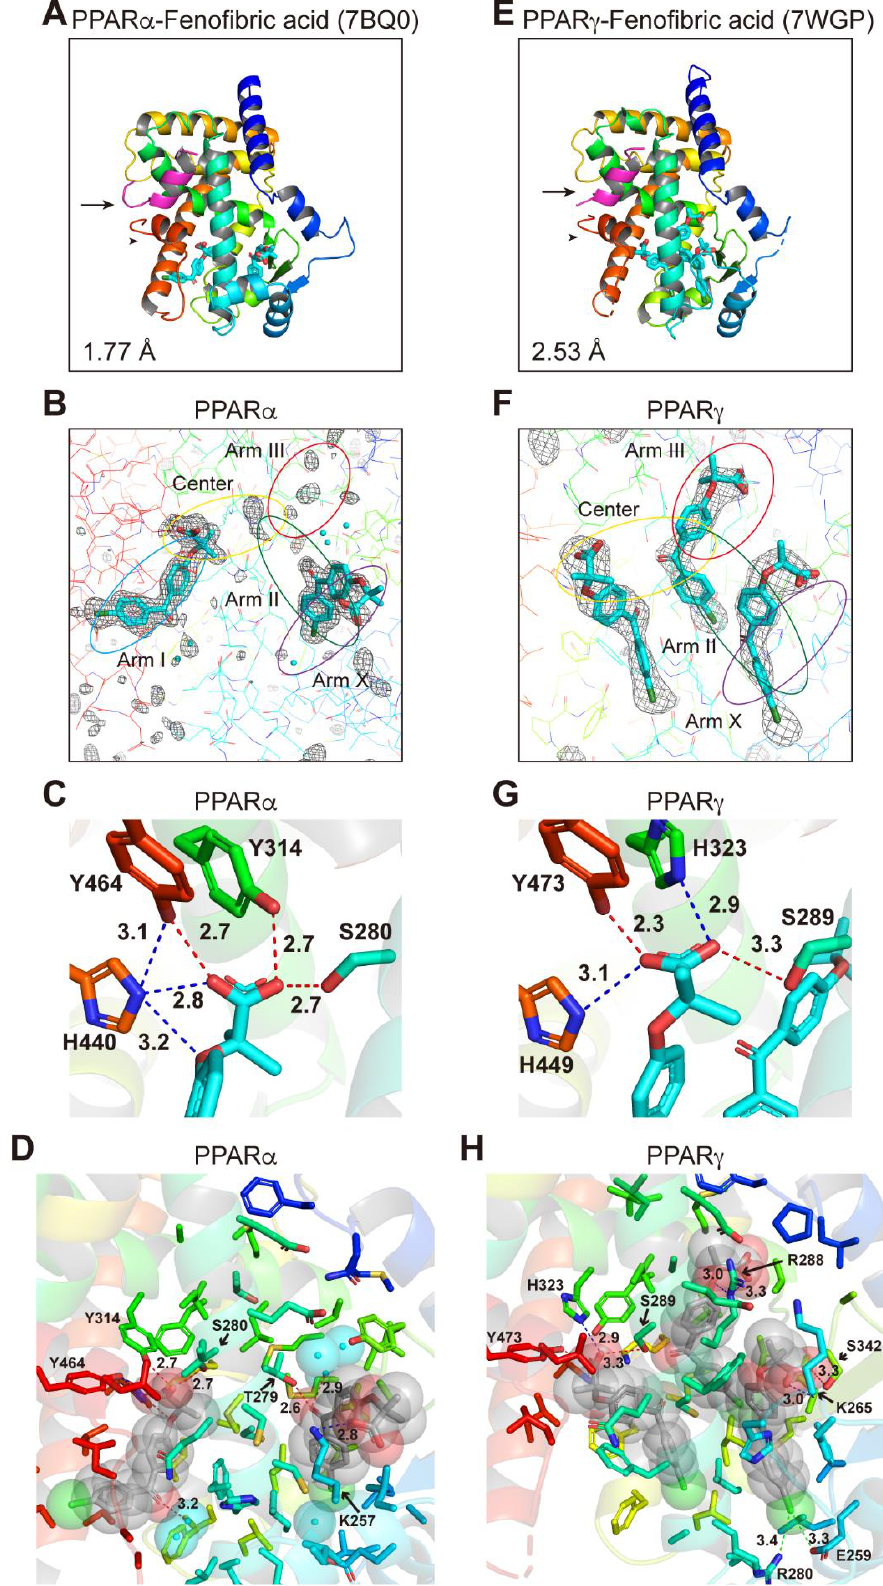
Figure 5. PPAR α / γ -LBD – fenofibric acid cocrystal structures. Cocrystals of fenofibric acid and PPAR α -LBD ( A – D ; reprinted from Kamata et al. [6]) or PPAR γ -LBD ( E – H ) were analyzed using X-ray diffraction. ( A , E ) Overall structures of the complexes. The SRC1 peptide ( α -helix in magenta) and the AF-2 helix 12 ( α -helix in red) are indicated by arrows and arrowheads, respectively. PDB identities and resolutions are labeled. ( B , F ) Magnified views of fenofibric acids located in Arm